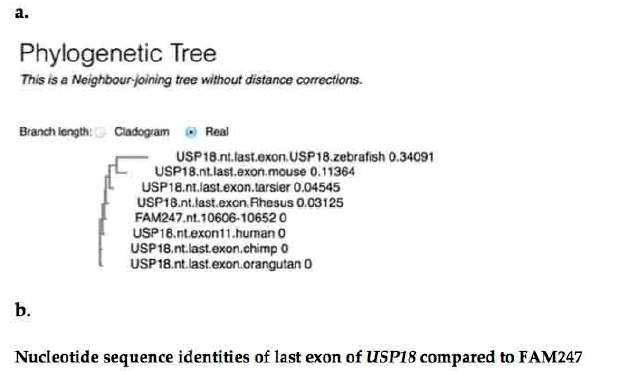
Table 2. USP18 gene and protein sequence identities and evolutionary time between species.